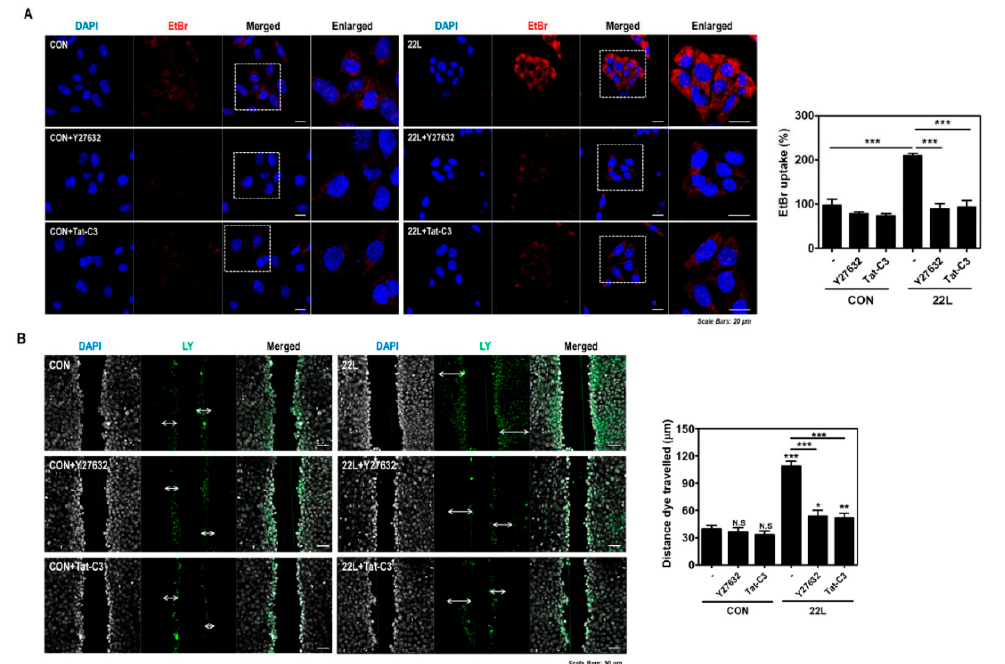
Figure 7. Inhibition of RhoA and ROCK reduced hemichannel function in scrapie-infected cells. ( A ) ZW13-2 cells with or without 22L scrapie infection were pretreated with or without 10 µ M Y27632 (middle panels) or 1 µ g / mL Tat-C3 (bottom panels) for 6 h and then incubated with 5 µ M EtBr for 5 min. The fluorescence signal was analyzed using a confocal microscope. Bar graph illustrates EtBr uptake normalized to and statistically compared to control. ( B ) Cells with or without 22L scrapie infection were incubated with 0.1% Lucifer yellow (LY) with or without Y27632 (10 µ M) or Tat-C3 (1 µ g / mL) treatment for 6 h. LY fluorescence was analyzed using a confocal microscope. Bar graph illustrates EtBr uptake normalized to and statistically compared to control. Statistical di ff erences were determined by one-way ANOVA with Tukey’s post hoc test ( n = 5, * p < 0.05; ** p < 0.01; *** p < 0.001).